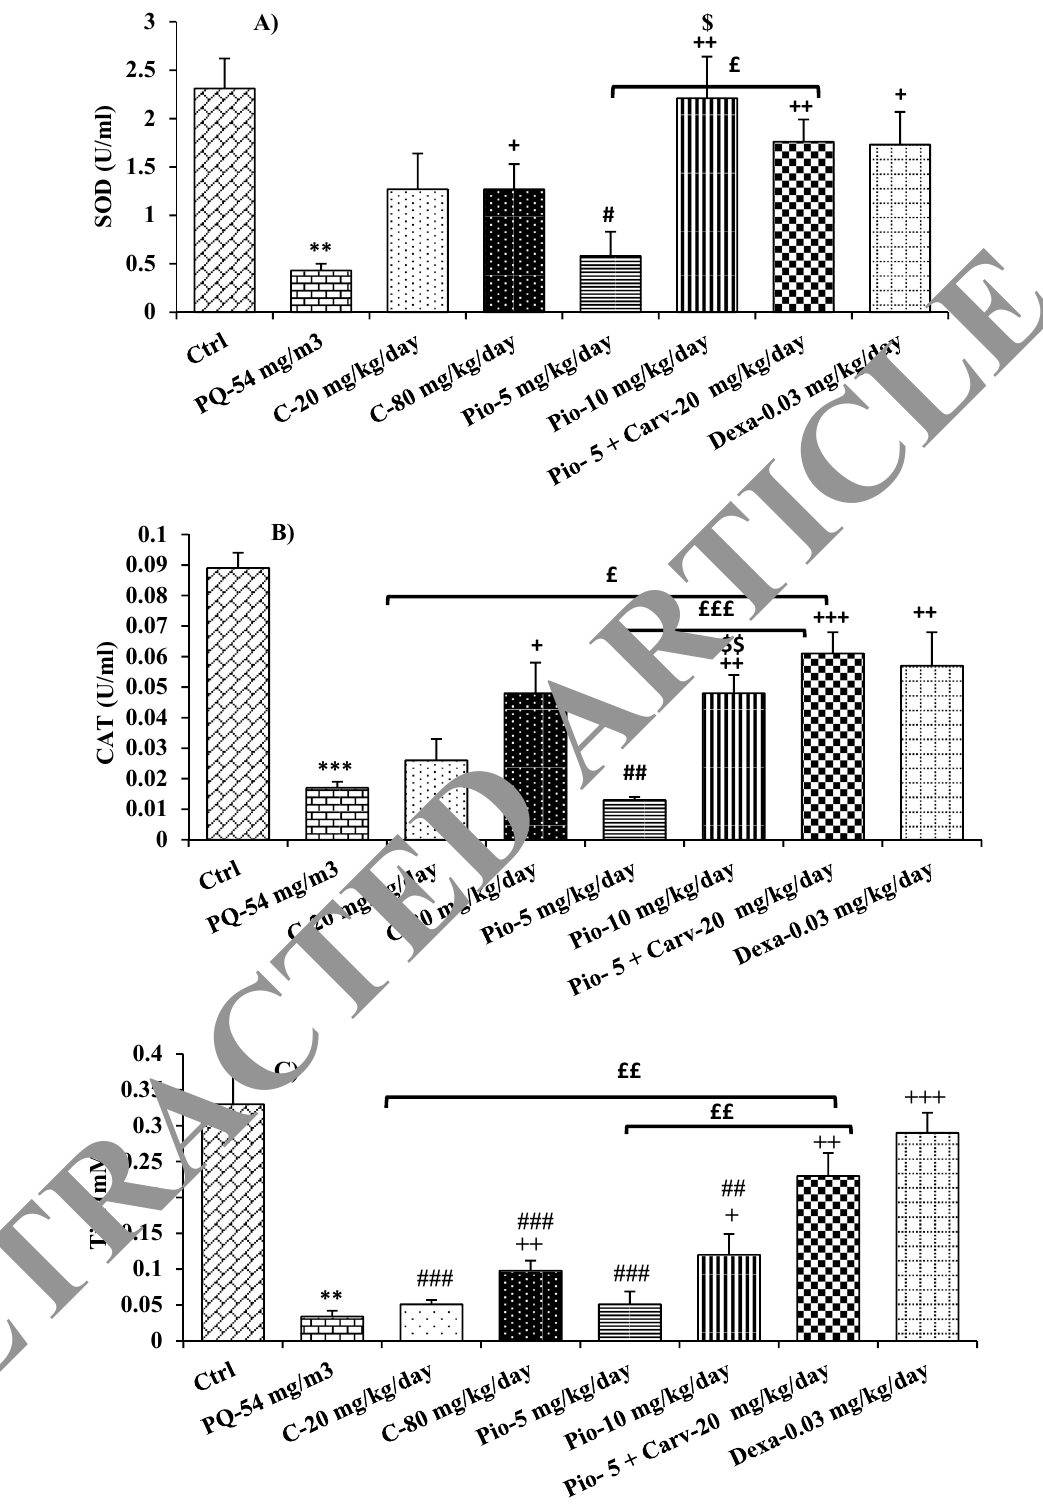
Figure 9. Comparison of SOD ( A ) CAT ( B ) activates and tiol ( C ) between control group (Ctrl), group exposed to paraquat aerosol at doses of 54 mg/m 3 (PQ-54 mg/m 3 ), groups exposed to PQ-54 mg/m 3 and treated with 5 and 10 mg/kg/day pioglitazone (Pio-5 mg/kg/day and Pio-10 mg/kg/day), 20 and 80 mg/kg/day carvacrol (C-20 mg/kg/day and C-80 mg/ kg/day), 0.03 mg/kg/day dexamethasone (Dexa-0.03 mg/kg/day) and 5 mg/kg/day pioglitazone + 20 mg/kg/day carvacrol (Pio-5 mg/kg + C-20 mg/kg). ** p < 0.01 and *** p < 0.001 compared to the control group. + p < 0.05, ++ p < 0.01, and +++ p < 0.001 compared to the PQ-54 mg/m 3 , # p < 0.05, ## p < 0.01 and ### p < 0.001 compared to dexamethasone, $$ p < 0.01 compared to Pio-5 mg/kg/day, £ p < 0.05, ££ p < 0.01 and £££ p < 0.001co mparison between Pio-5 and C-20 with Pio-5 mg/kg/day + C-20 m g/ kg/day group. Data are presented as mean ± SEM (n = 6 in each group). Comparisons between different groups were made using one-way ANOVA followed by Tukey’s multiple comparison